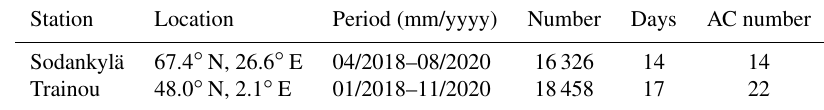
Table 2. Locations of AirCore sites and amount of satellite data compared to AirCore. “Number” gives the total number of single satellite footprint collocations, “Days” the number of days with collocations, and “AC number” the number of collocated AirCore profiles.